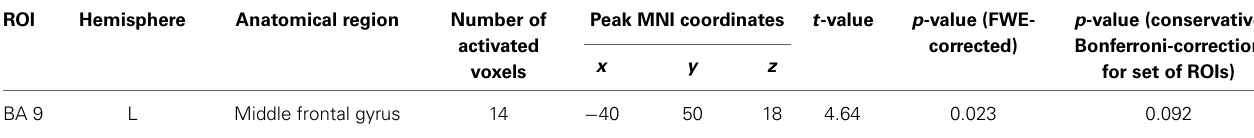
Table 3 | Cerebral activation associated with a negative load × age interaction during CBT retrieval. ROI Hemisphere Anatomical region Number of